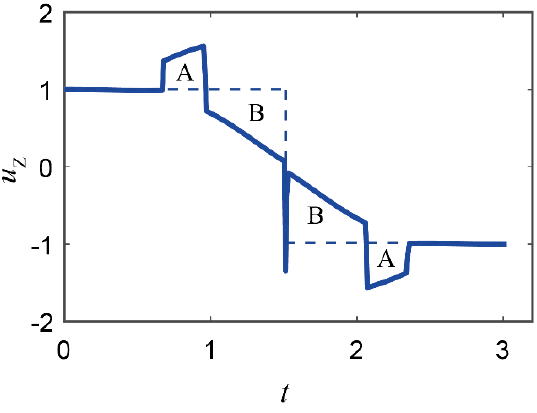
Figure 7. The control component uZ along inertial Z axis for Case